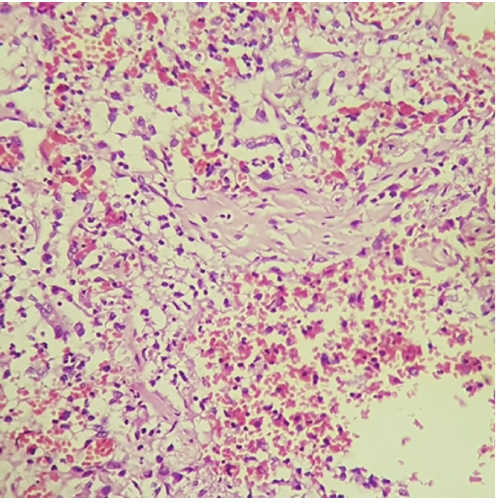
Figure 7a - Lung tissue with ARDS/DAD (diffuse alveolar damage): Masson's bodies and autophages. A, Exudate from mononuclear cells with erythrocytes admixture in lumen of respiratory alveoli with polypoid connective tissue nodule - Masson's bodies with foci of organizing pneumonia. Hematoxylin and eosin, х100.